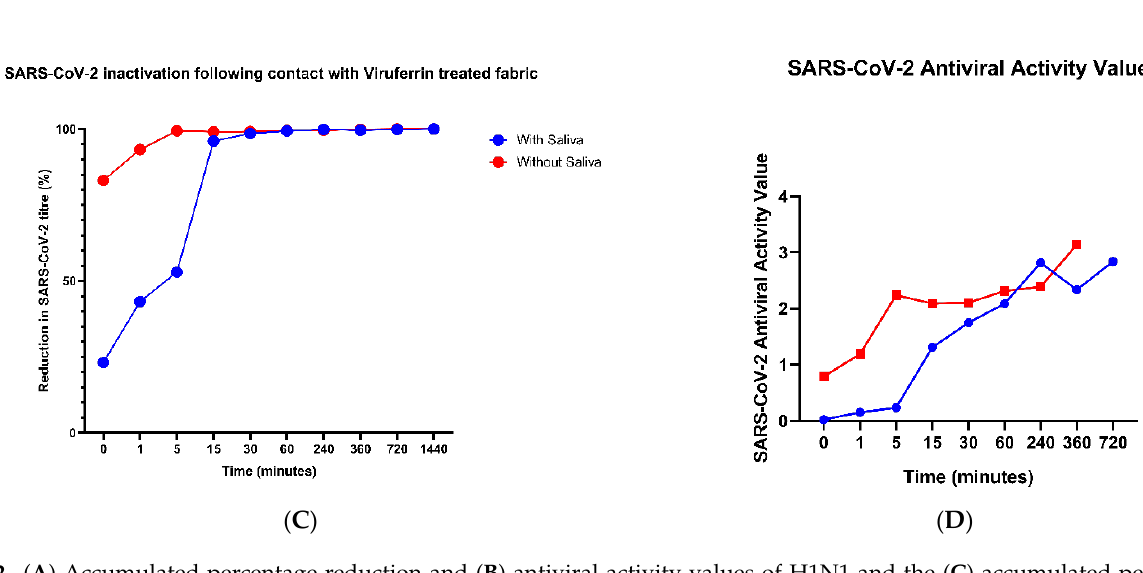
Figure 3. The stability of the Viruferrin treated fabric material was assessed by washing the treated fabric material either 5 or 10 times. Each assay was conducted in triplicate with an unwashed non-treated fabric as control. Each individual inoculated well containing SARS-CoV-2 was wiped, with a single action, per piece of fabric. The viral titer of each well